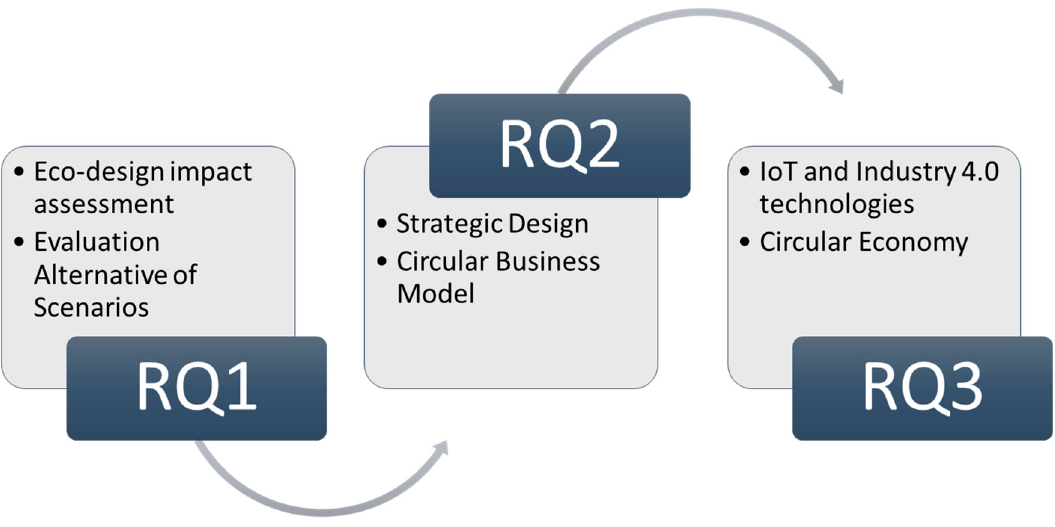
Figure 1. Conceptual diagram explaining the methodology adopted (RQ = research question; IoT = Internet of Things).